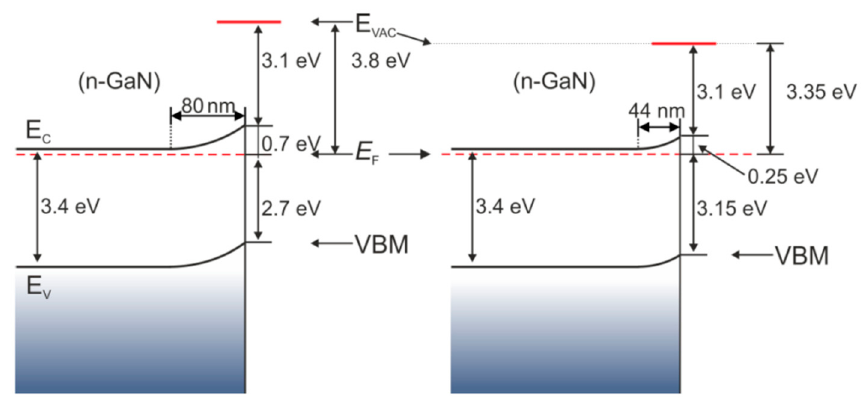
Figure 7. Energy band diagram for n-GaN(0001) in the dark ( left ) and illuminated with UV photons ( right ). Reprinted with permission from [64]. Copyright 2020 Elsevier.